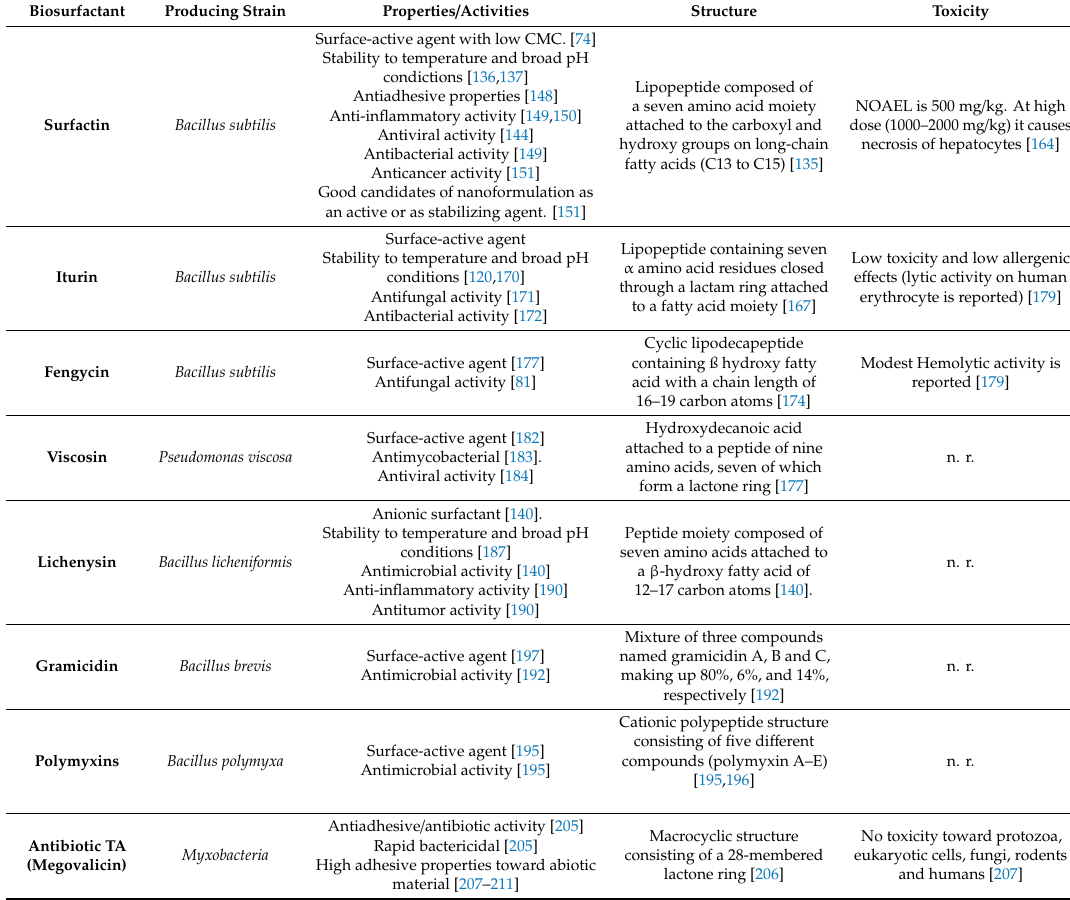
Table 2. Biosurfactants with lipopeptidic and lipoproteic structure (n.r. = not